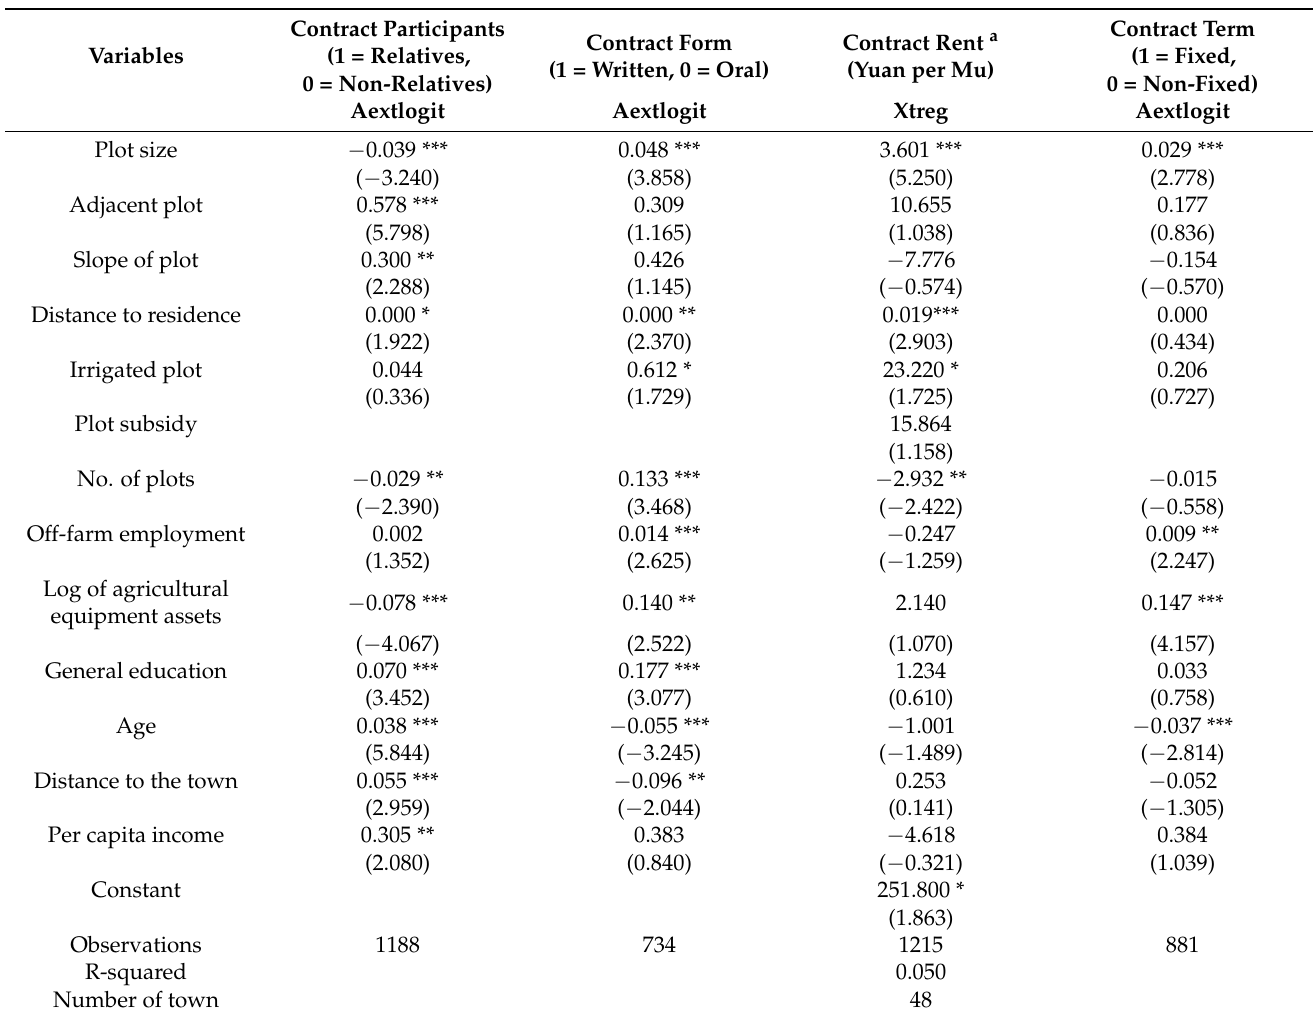
Table A2. The impact of the size of rented-in plots on contract choice with town fixed